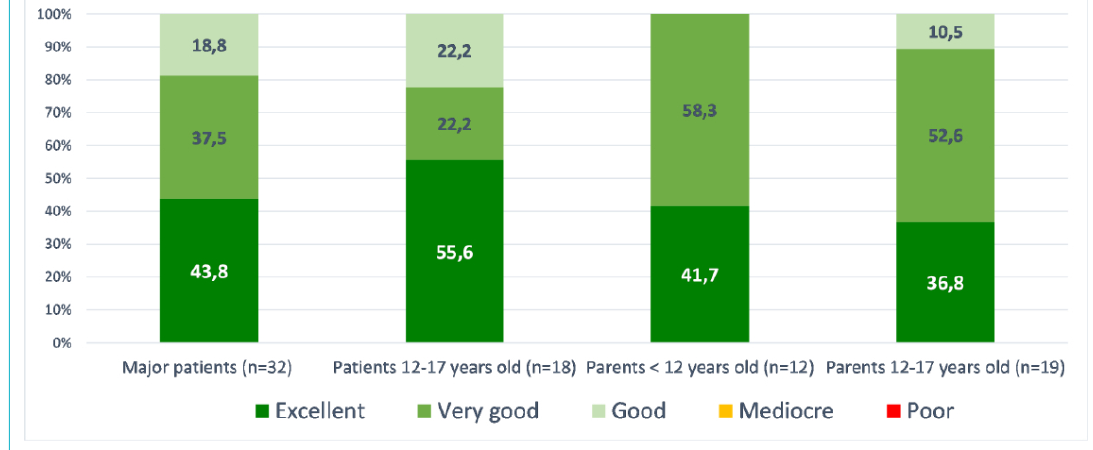
Figure 4: Degree of satisfaction of the LTFU program; evaluation of the satisfaction level concerning the LTFU program by group (major pa- tients [n = 32]; patients 12–17 years old [n = 18]; parents <12 years old [n = 12]; parents 12–17 years [n =